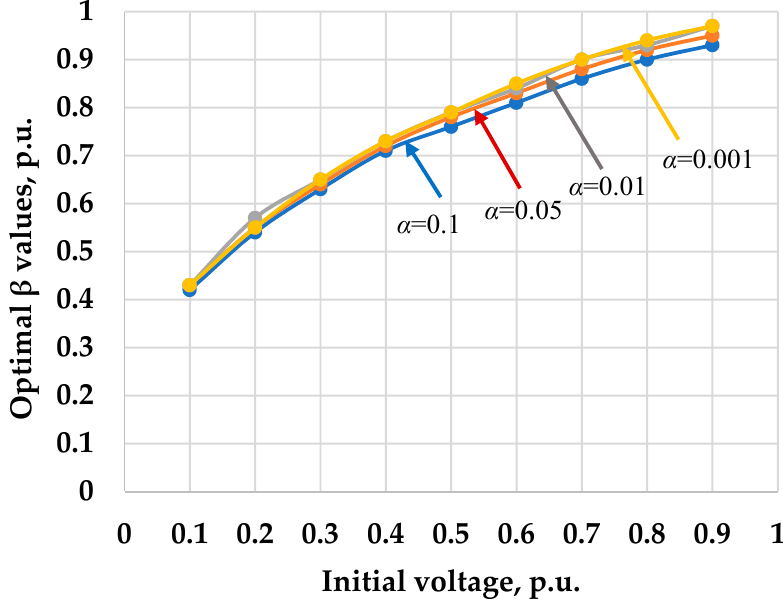
Figure 6. Optimal coefficient β values in RC-R circuit with the supply of a constant power source versus initial capacitor voltage.